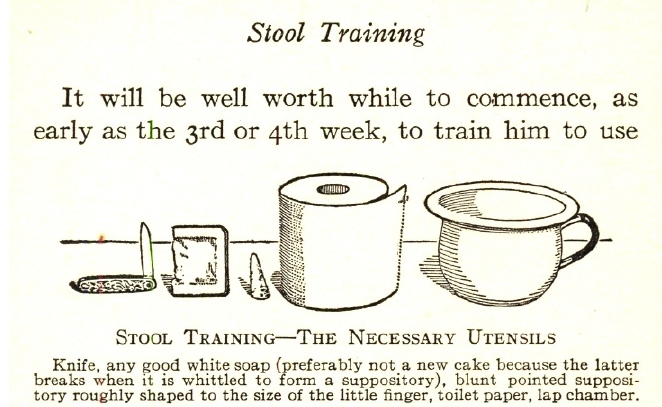
Figure 14. All the Necessary Items for Early Bowel Training.